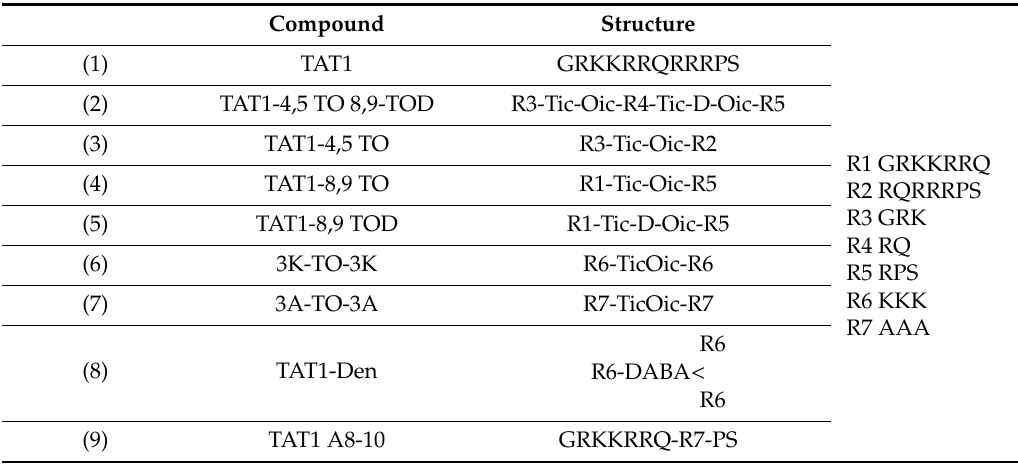
Table 1. TAT1 derivatives explored in this study. Compounds (7) and (9) constitute negative controls. Compound